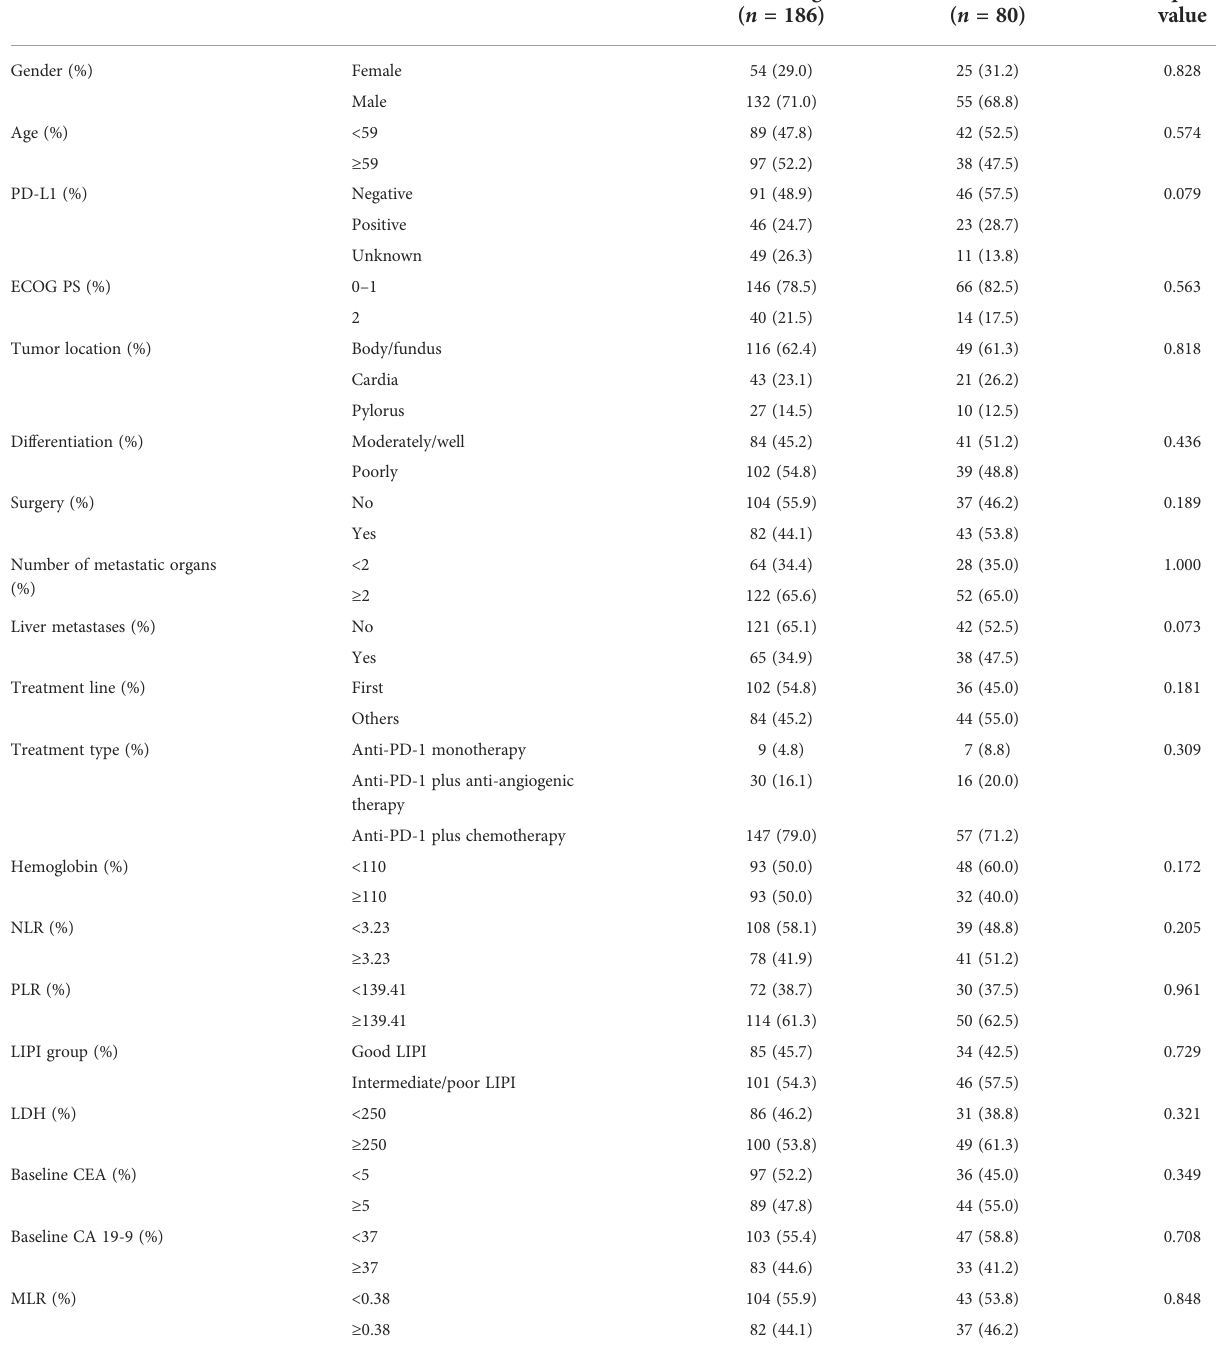
TABLE 1 Patient characteristics of the training cohort and the validation